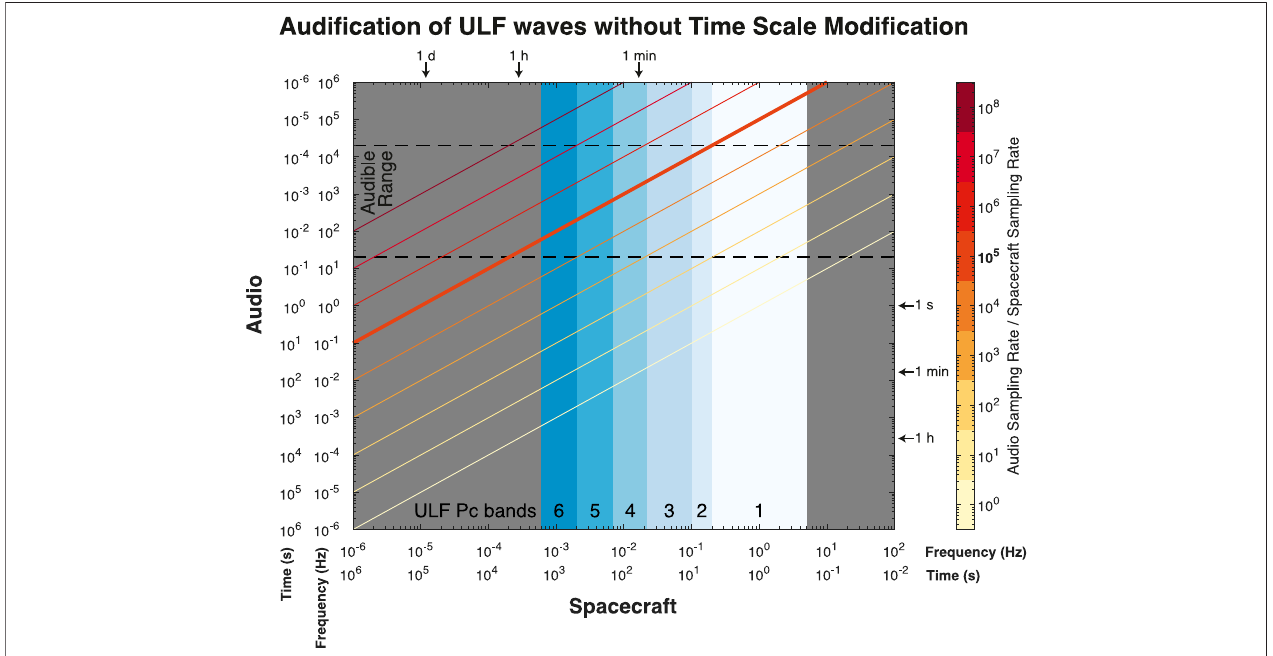
FIGURE 1| Relationship between spacecraft time and frequency to audio time and frequency in audi fi cation for different ratios ofsampling rates. ULF wave bands are also highlighted.